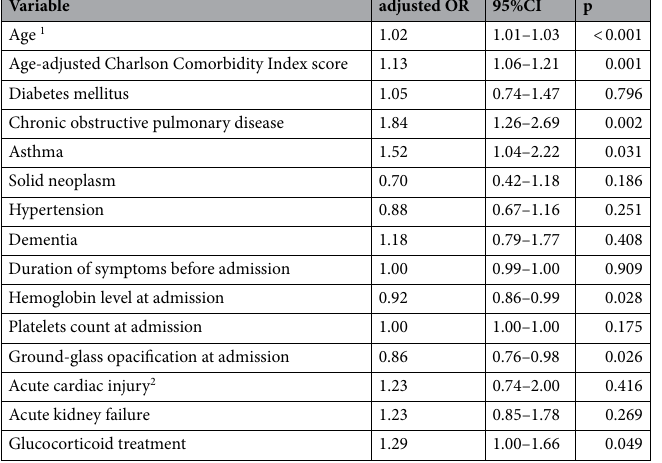
Table 3. Final multivariate analysis of variables related to risk of readmission in patients with COVID-19. 1 Per one-year increase. 2 Acute cardiac injury: acute myocardial infarction, heart failure, arrhythmia or